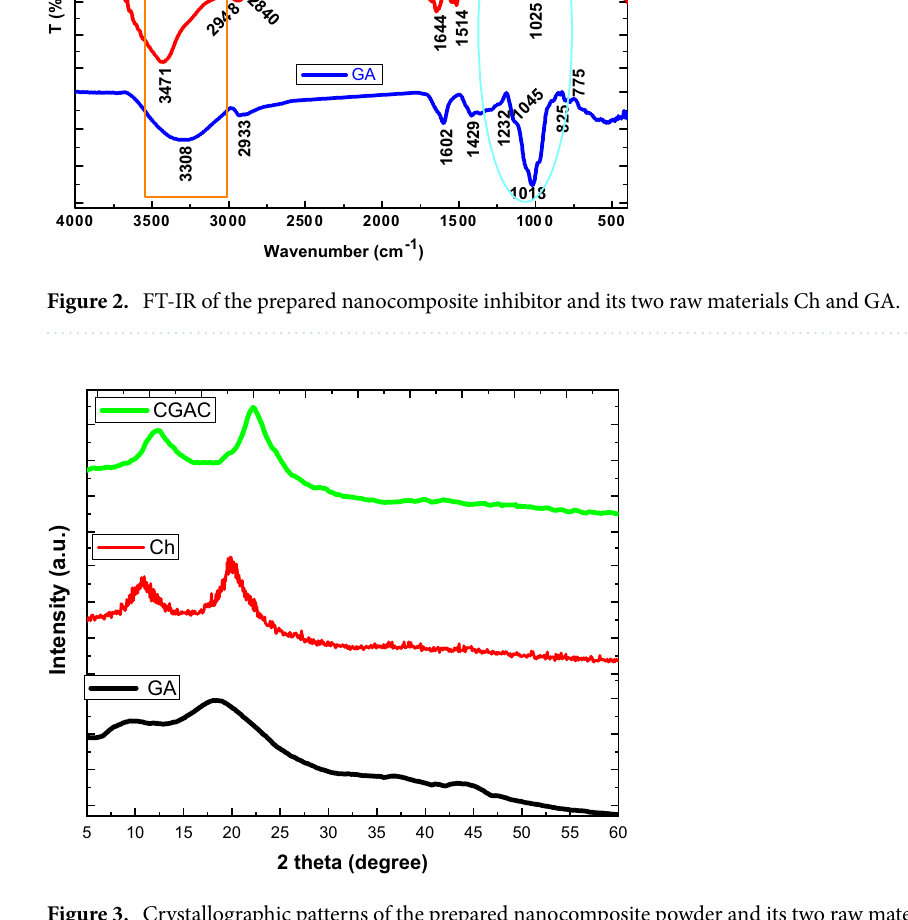
Figure 3. Crystallographic patterns of the prepared nanocomposite powder and its two raw